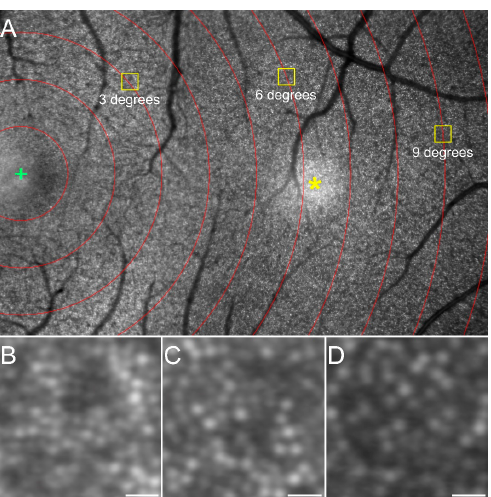
Figure 1. Example of a healthy cone mosaic on high magnification module imaging in the central and temporal gaze direction ( A ). The green cross marks the location of the fovea. The red lines indicate the corresponding retinal eccentricities. The yellow squares indicate selected ROIs, depicted magnified at approximately 3 degrees ( B ), 6 degrees ( C ) and 9 degrees ( D ) eccentricity. A typical artifact of high magnification module images is visible as a large bright spot (asterisk). Scale bar: 20 µ